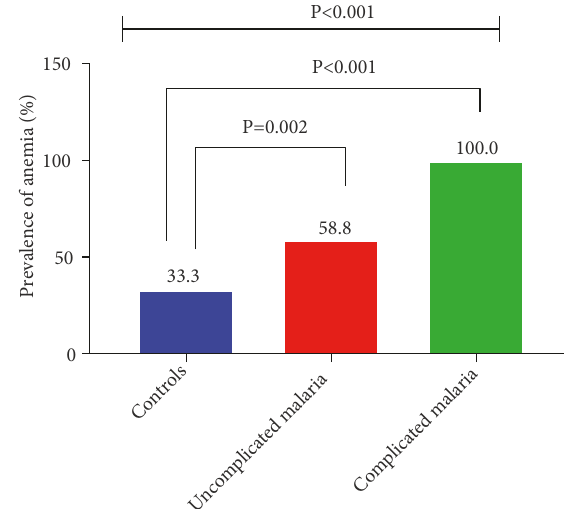
Figure 1: Prevalence of anemia among control, uncomplicated, and complicated malaria